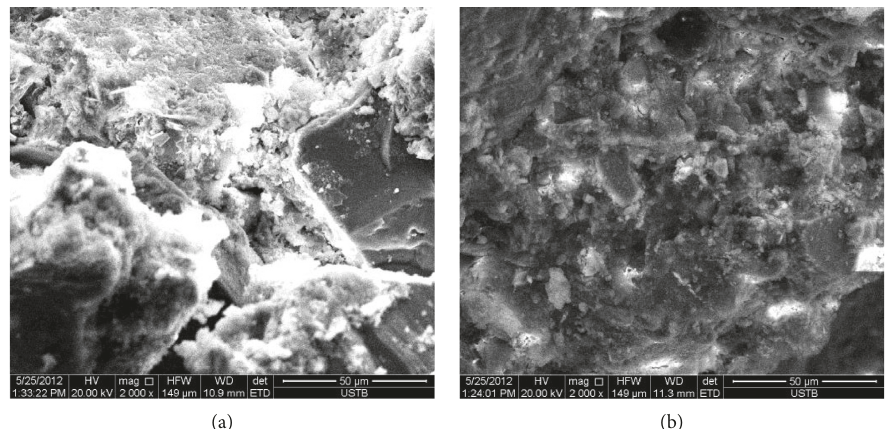
Figure 7: SEM analysis of saline soil solidified using the two solidifying materials after standard curing 28 d. (a) Solidification using cement. (b) Solidification using our improved material.